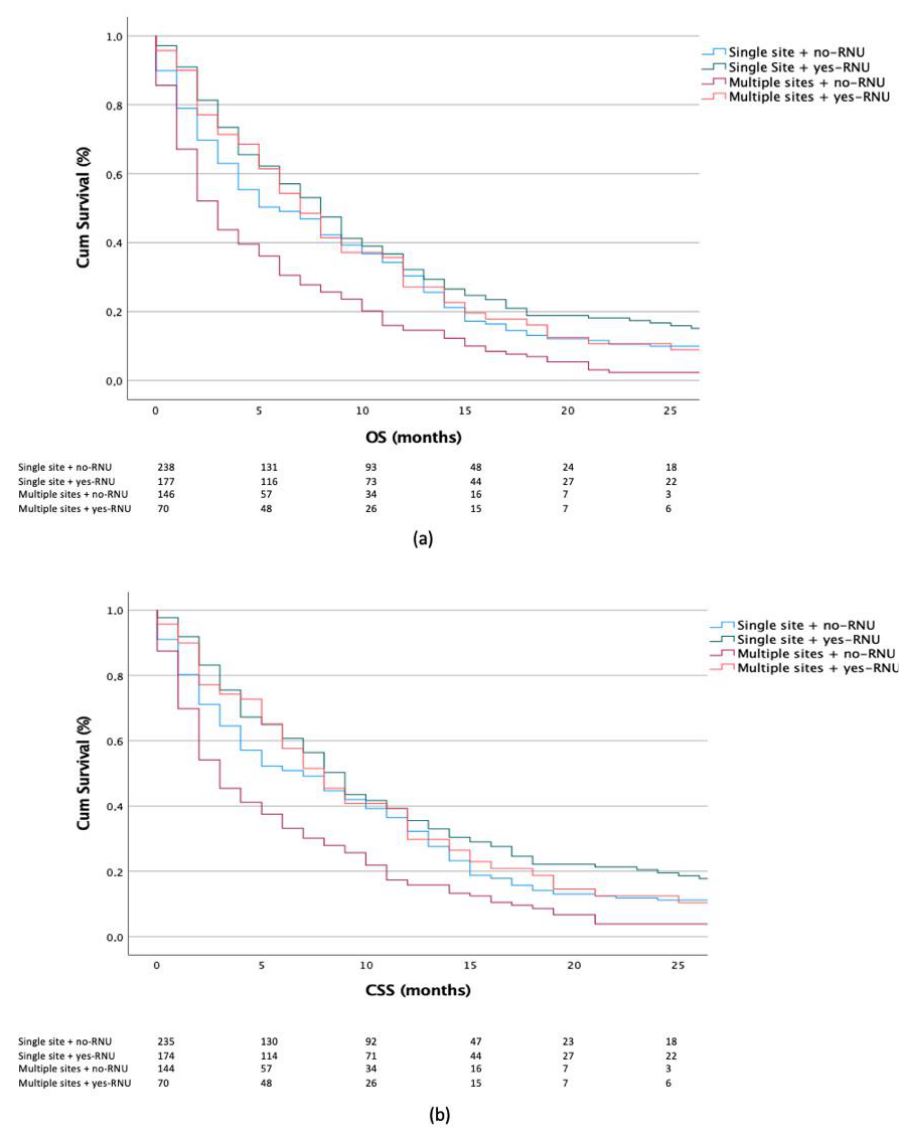
Figure 4. Kaplan–Meier plots depicting OS ( a ) and CSS ( b ) according to radical nephroureterectomy (RNU) treatment in patients with single- vs. multiple-organ metastases. Table 2. Multivariate Cox regression analysis of factors that influenced OS and CSS